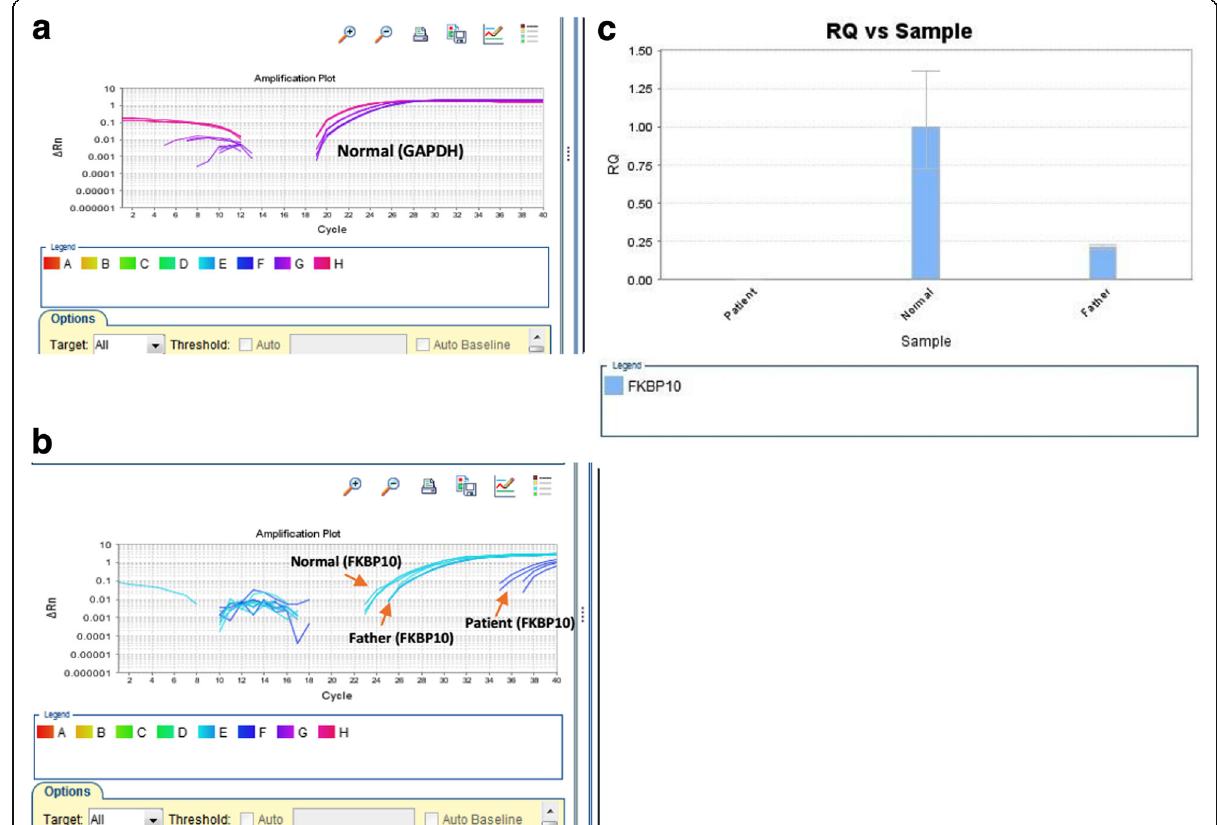
Fig. 4 Real-Time analysis of GAPDH and FKBP10 gene in the patient, his father and normal individual. a ). As seen in this figure, GAPDH expression shows same levels for the patient, his father and normal individual b ). Comparison between expression levels of FKBP10 shows different levels in the proband, heterozygous individual and normal individual c ). Relative quantification (RQ) result. It shows that normal individual (the calibrator) has a RQ value of 1 meaning no changes in its expression level but in the proband RQ is zero which indicates no expression of FKBP10 . In his father, the gene is 75 times less